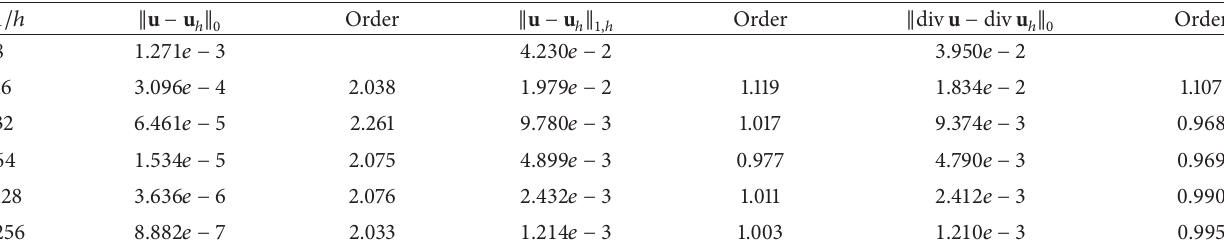
Table 1: 𝜇 − = 1 , 𝜇 + = 100 , and 𝜆 = 5 𝜇 .